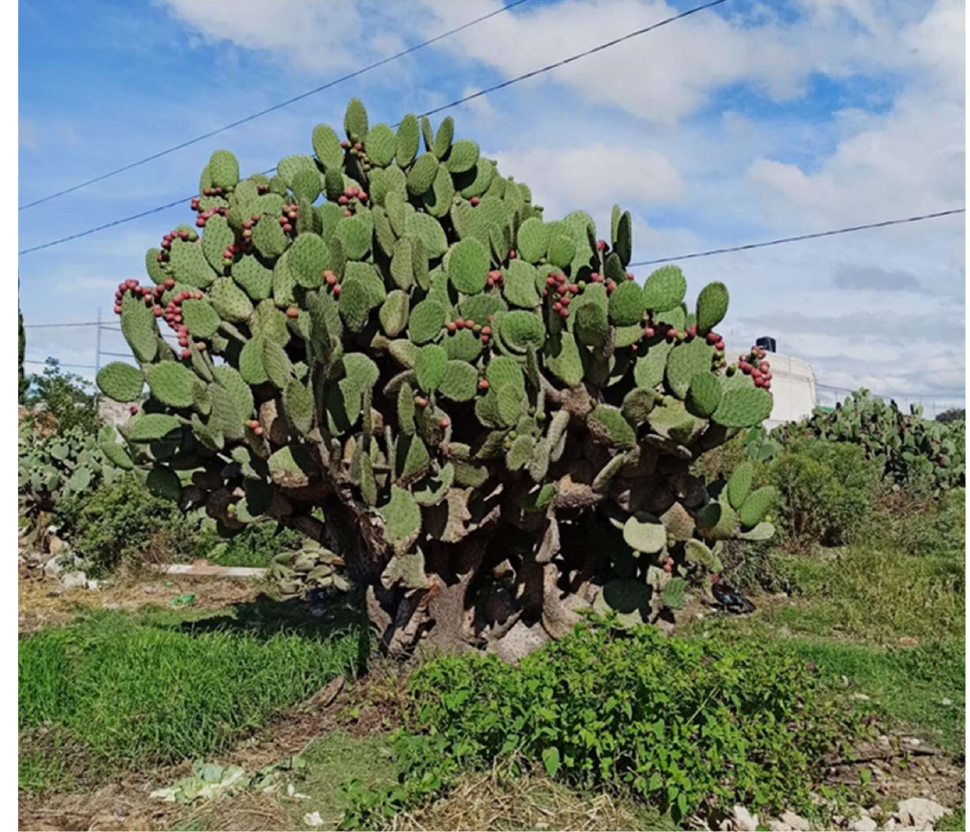
Figure 15. Impression of one of the proposed Crassulacean acid metabolism (CAM) plants for bioenergy cropping systems in marginal African drylands: the perennial multipurpose crop opuntia ( Opuntia ficus-indica (L.) Mill.), also known as ‘nopales’, which can grow over 2 m tall.